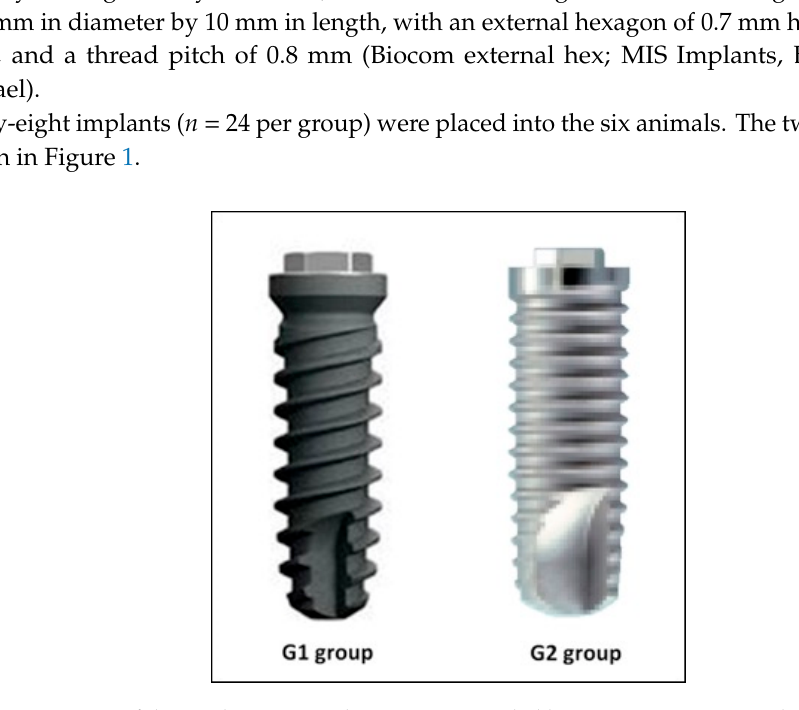
Figure 1. Images of the implants assayed, comparing guided bone regeneration in induced buccal wall defects. Both implants had similar microgeometry.